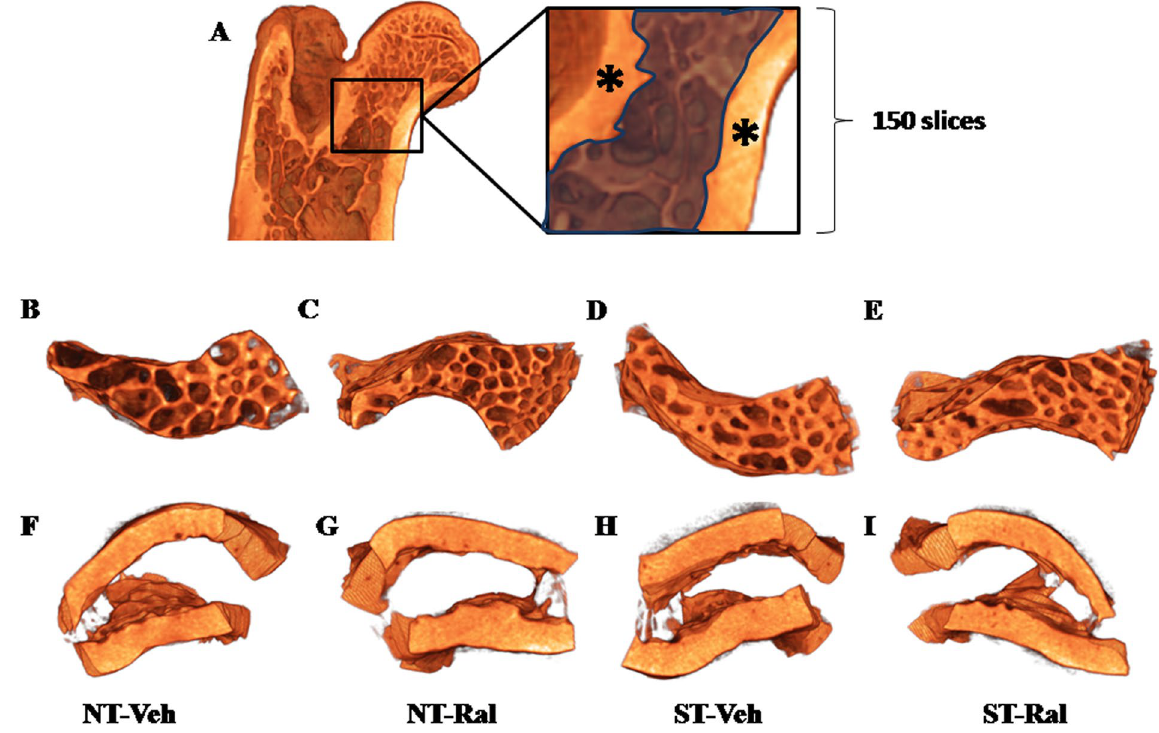
Figure 2. Characterization of 3D morphometric analysis. ( A ) Scanned image of proximal epiphysis, with dimensions of the region of interest (femoral neck) indicated. The region of interest in the trabecular femoral neck is marked by crosshatched and the cortical femoral neck is marked by * . The 3D images show a typical example of trabecular and cortical bone in the femoral neck of animals that did not undergo strength training (NT-Veh – B and F ), animals who did not undergo strength training but received raloxifene (NT-Ral – C and G ), animals who underwent strength training (ST-Veh – D and H ) and animals who underwent strength training and received raloxifene (ST-Ral – E and I